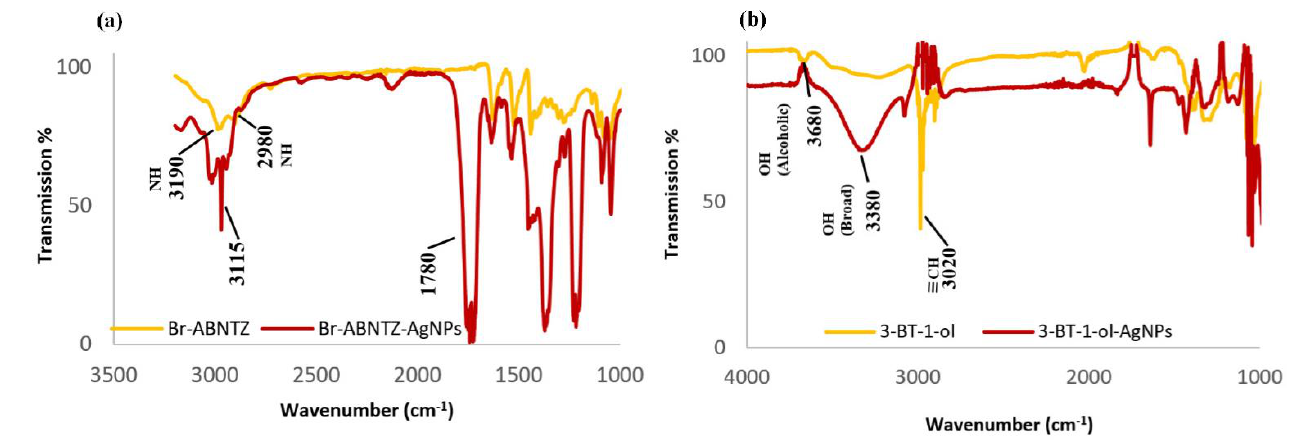
Figure 3. Representative FTIR (Thermo Fisher Scientific MicromATR Vision TM Nicolet IS-5) spectra of ( a ) ( 5-np ) (shown in red) and corresponding organic ligand 5 (shown in yellow) along with ( b ) 3-butyn-1-ol-AgNPs ( 11-np ) (shown in red) and corresponding organic ligand 11 (shown in yellow).